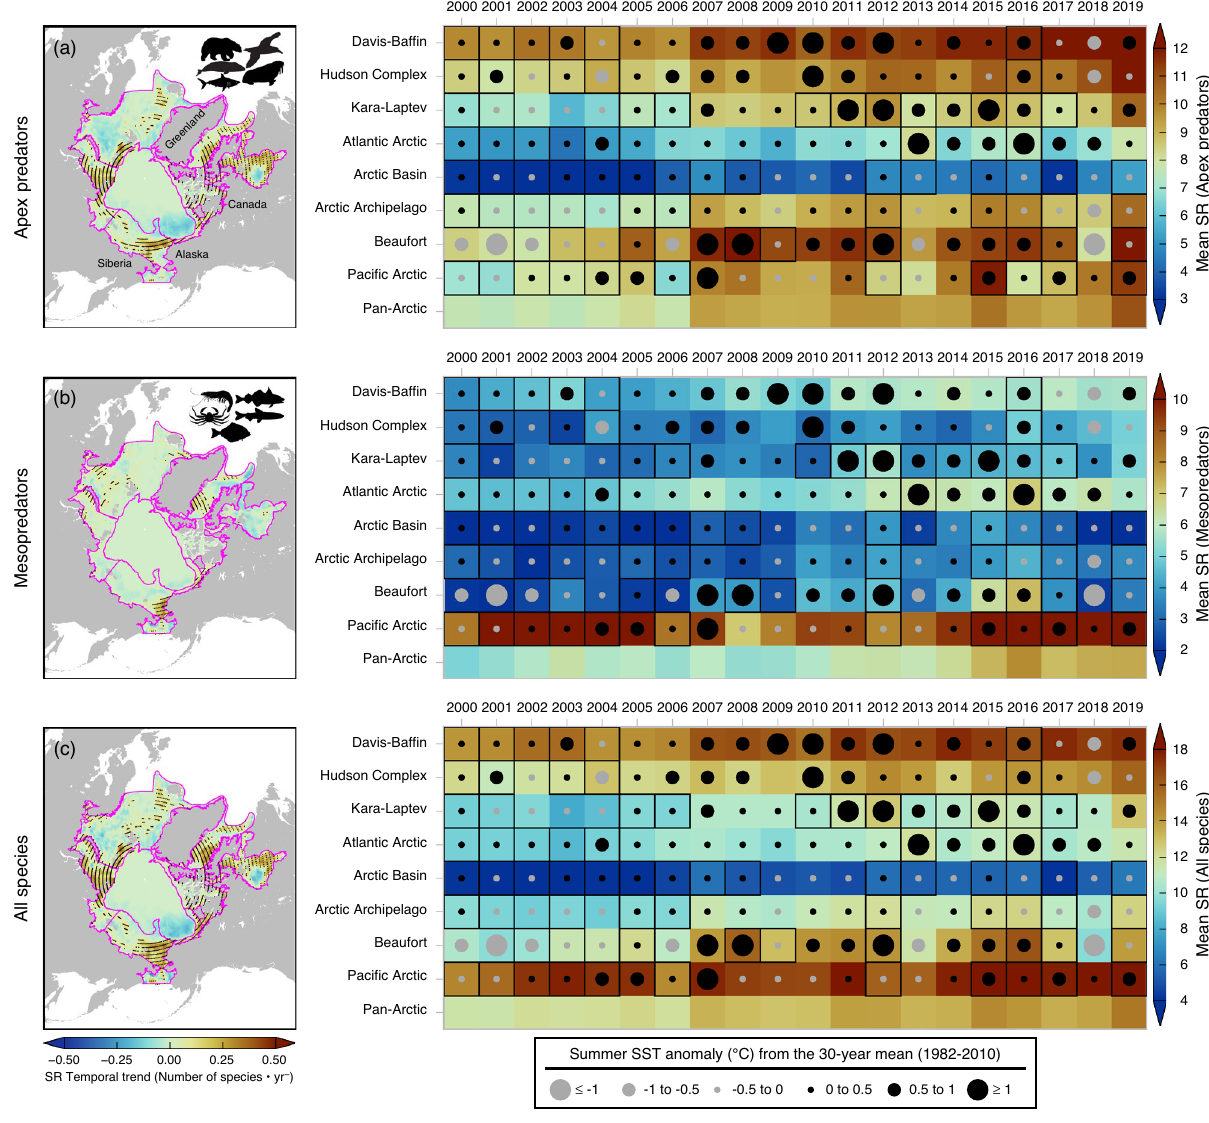
Figure 2. Distribution of temporal trends of species richness (left panels) and Hovmöller plots (right panels) of annual averaged species richness in areas of species accrual (pixels with species gain ≥ 1 species/decade, represented by the black dots in the left panels) for ( a ) apex predators, ( b ) mesopredators, and ( c ) all species from 2000 to 2019. Years with lower than regionally-averaged summer sea ice are indicated in solid squares and scaled magnitudes of summer sea surface anomaly relative to the long-term mean (1982–2011) are represented by shaded circles. The maps were created using GMT 6.3.0 (https:// docs. gener ic- mappi ng- tools. org/6. 3/ gmt.